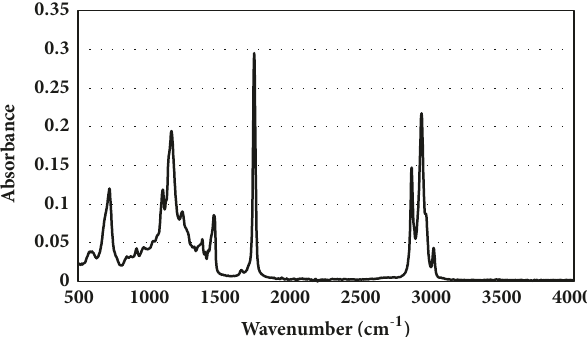
Figure 1: Interpolated map of the average “as received” nut mass at each location.